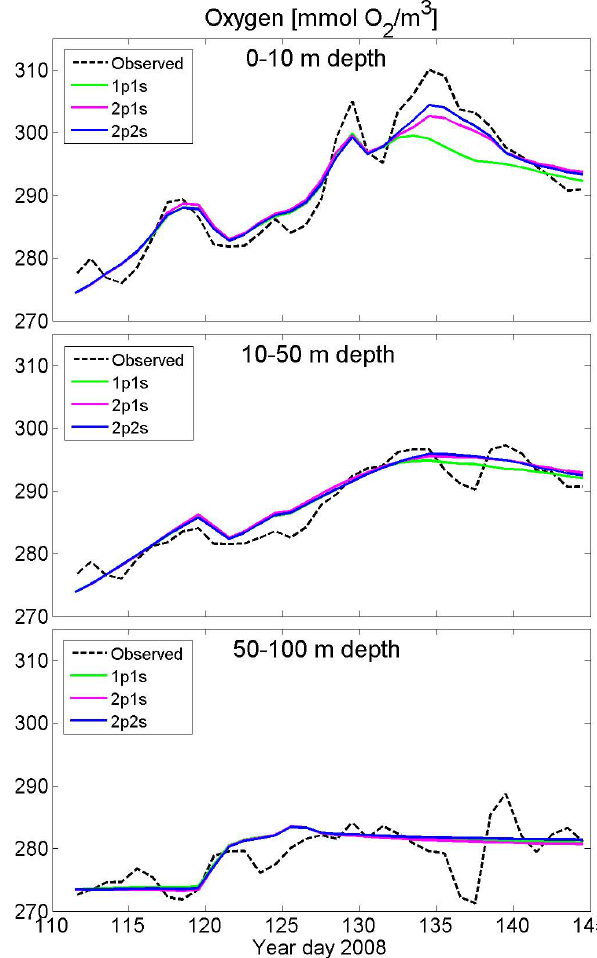
Fig. 7. Observed and simulated mean oxygen concentrations for different depth